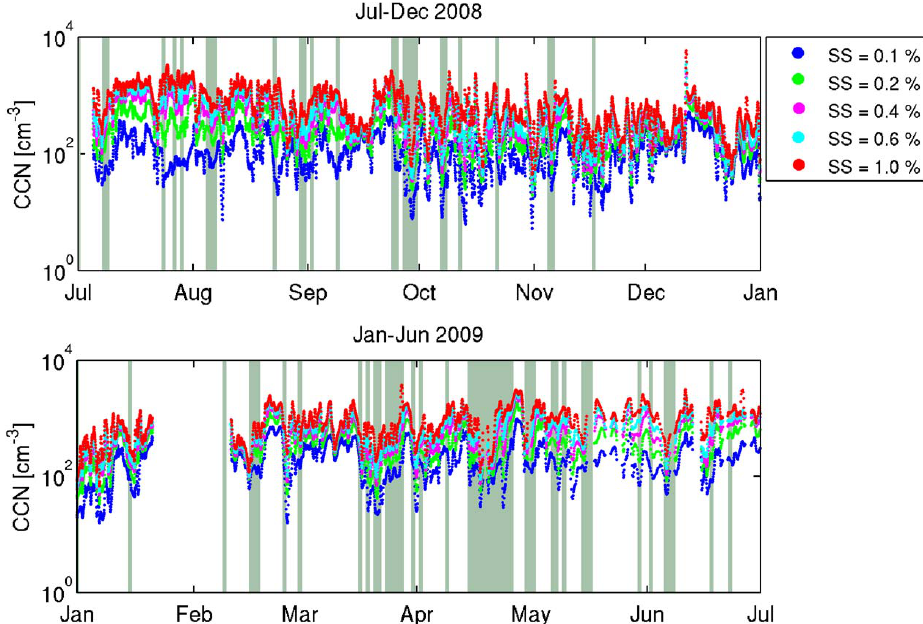
Fig. 1. Time series of CCN concentration at Hyyti¨al¨a SMEAR II station measured at five water supersaturations ( SS ): 0.1% (blue), 0.2% (green), 0.4% (purple), 0.6% (light blue), 1.0% (red). The data points are 1 hour averages, which have been smoothed by taking a moving average with a 10 points window. Days with new particle formation (event days) are marked with a grey